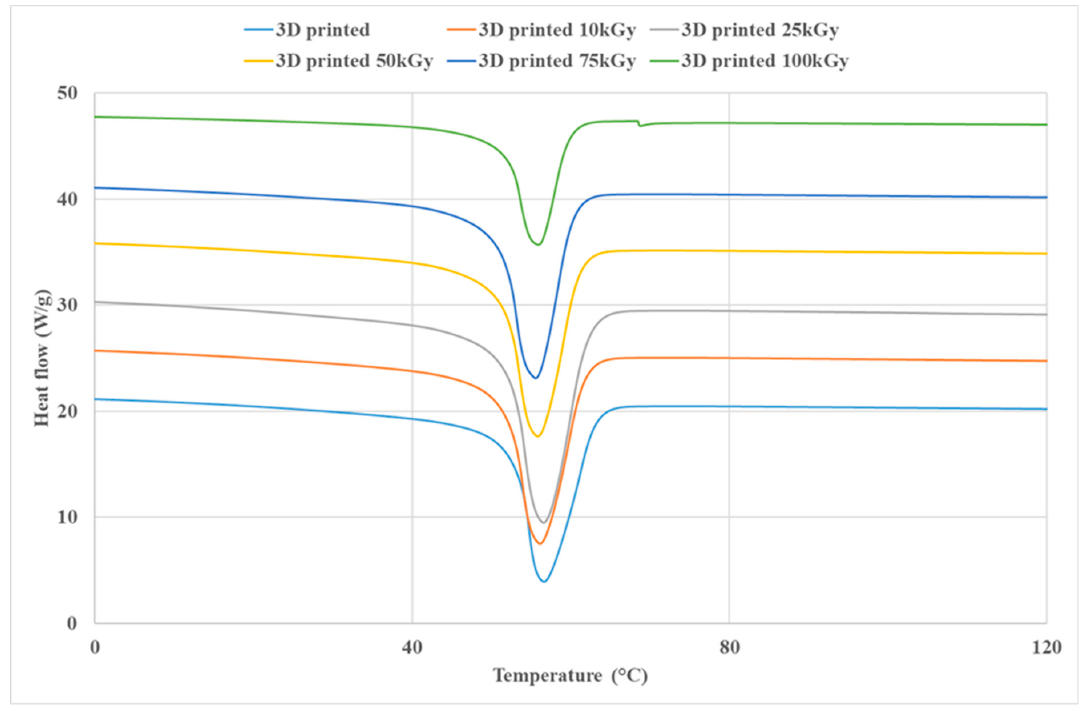
Figure 3. Thermograms of the second heating run of 3D-printed PCL samples after EB treatment at various doses.